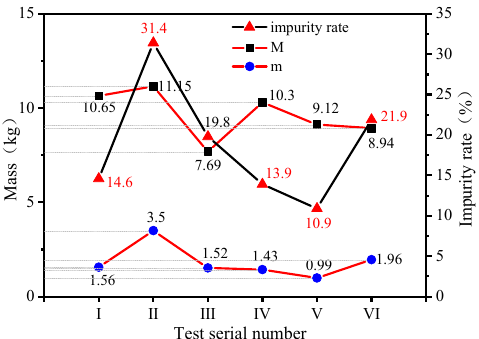
Figure 14. Field test results.